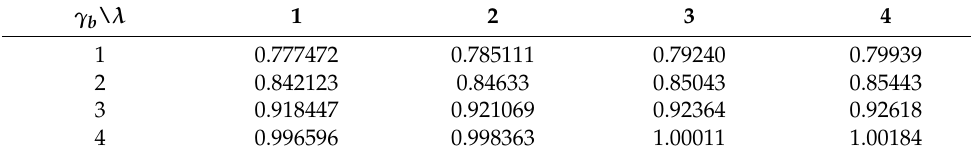
1 2 e for λ versus γ b